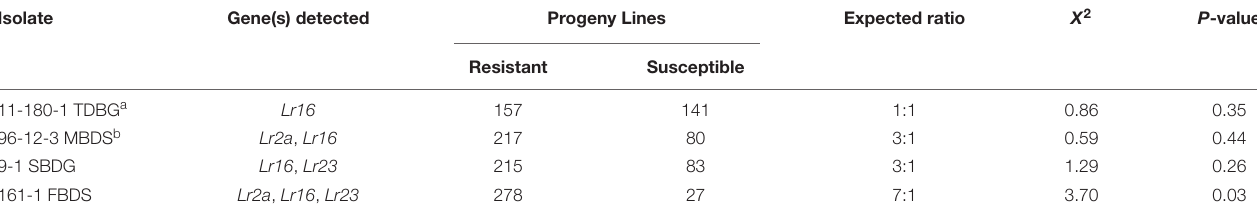
TABLE 2 | Reaction of the Carberry/Thatcher population against P. triticina isolates at the seedling stage. Isolate Gene(s) detected Progeny Lines Expected ratio